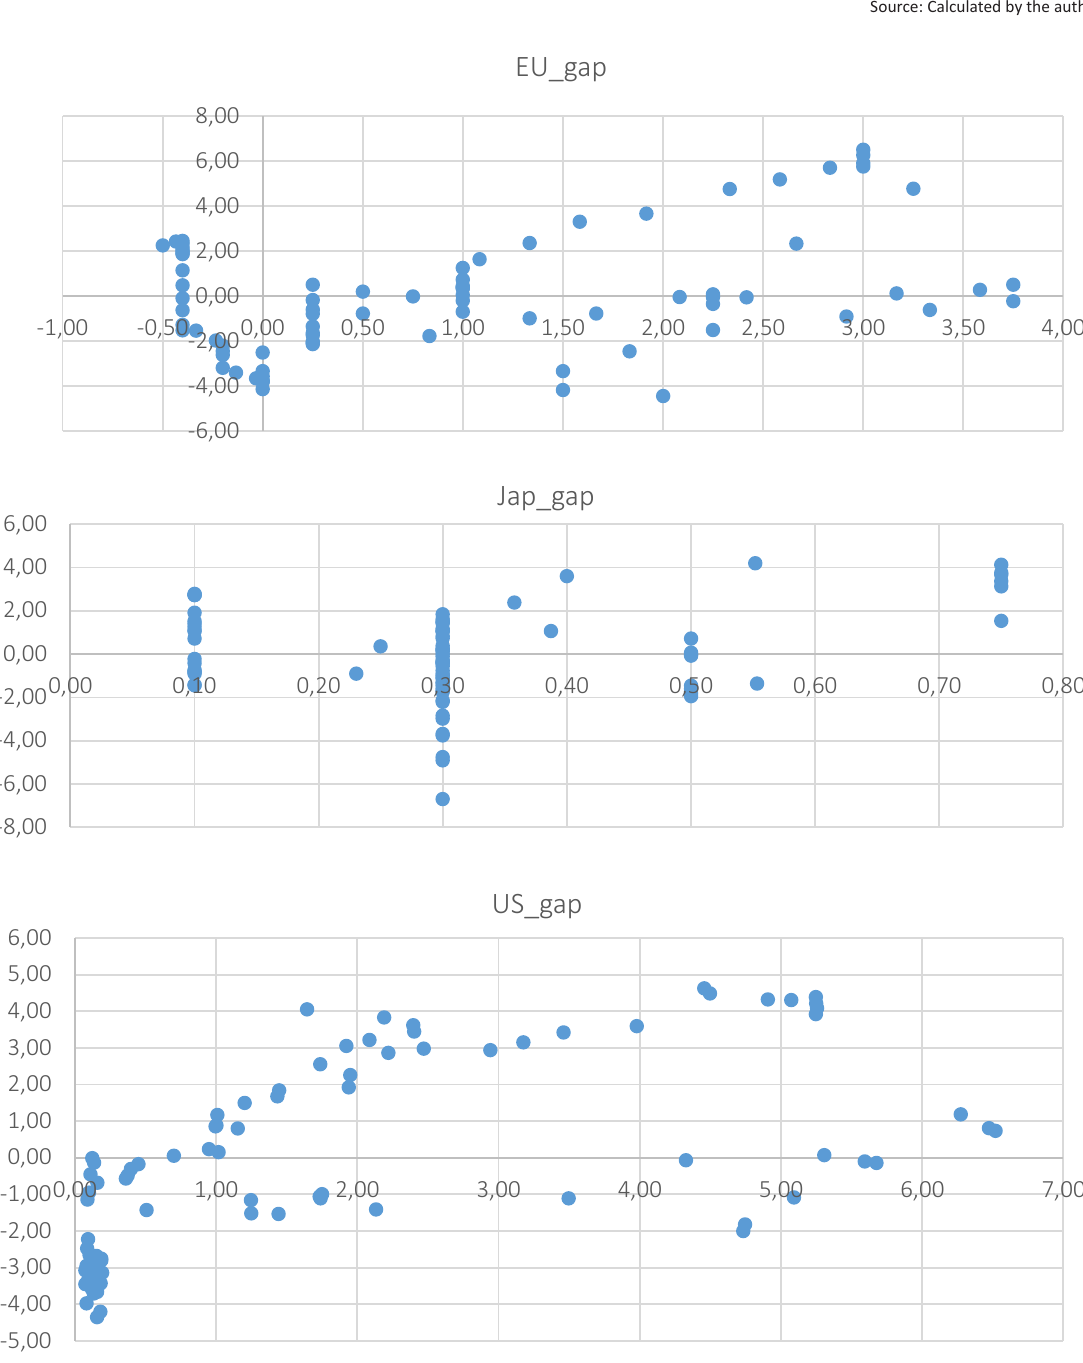
Figure 3. Dependence of the GDP gap and the dynamics of the key rate in selected